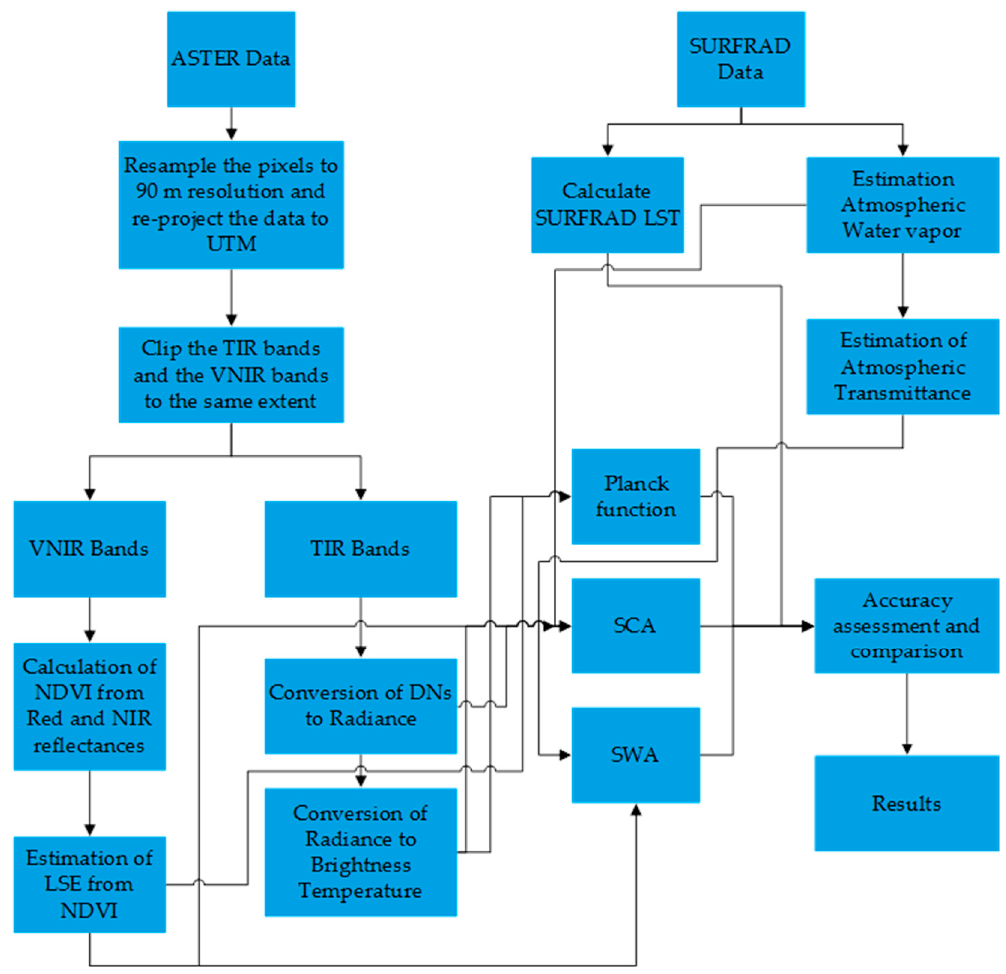
Figure 1 . Methodology used in the study. Figure 1. Methodology used in the